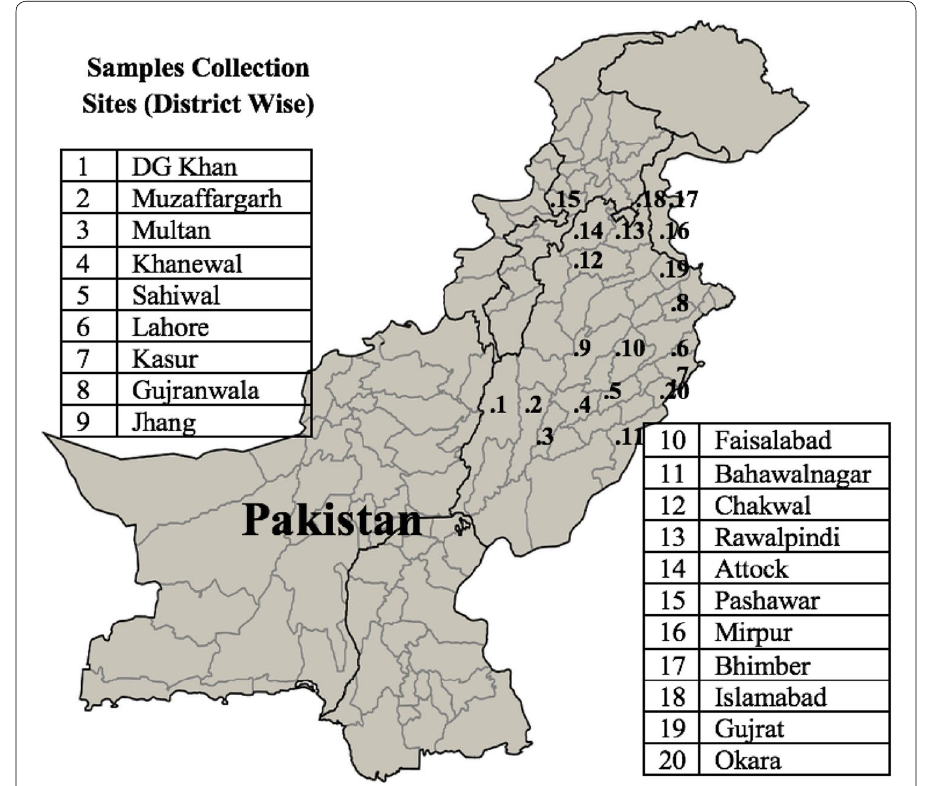
Fig. 1 Samples collection map (district